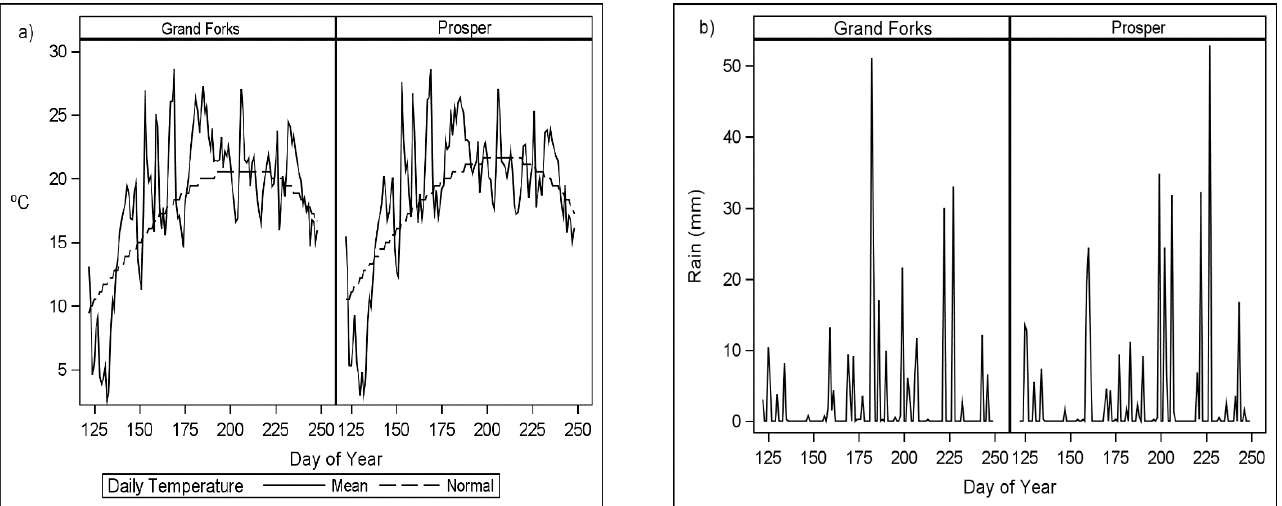
Figure 2. Wheat growing season ( a ) daily mean and normal temperatures and ( b ) daily rainfall in 2020 where day of year 125 is 4 May.